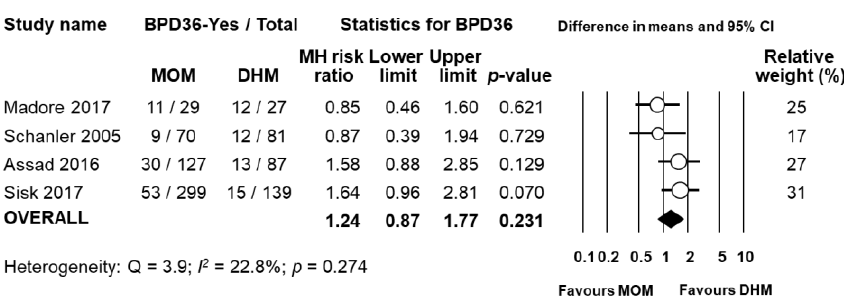
Figure 7. Meta-analysis of observational studies assessing the effects of receiving mainly MOM vs. receiving mainly DHM, on risk of BPD36. Circles (O) represent the effect sizes per study, and their size represents the relative weight of the study in the meta-analysis. Diamonds ( ◆ ) represent the pooled effect size. MOM: mother’s own milk; DHM: donor human milk; BPD36: bronchopulmonary dysplasia defined as oxygen dependency at 36 weeks post-menstrual age; MH: Mantel-Haenszel.